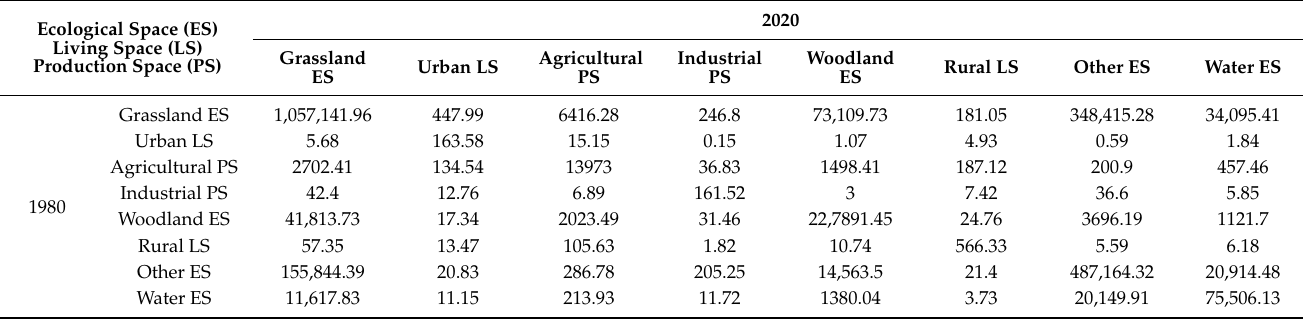
Table A5. Transfer matrix of land use structure change from 1980 to 2020 (km 2